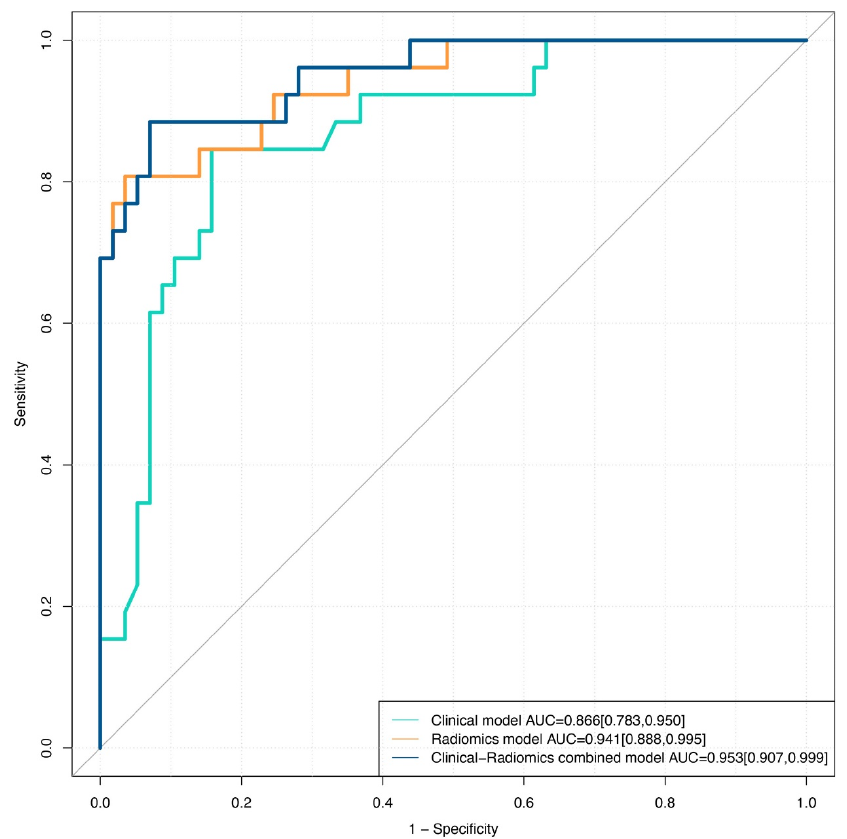
Figure 5. Comparison of ROC curves for differentiation of the three models for predicting PCa in the validation cohort.